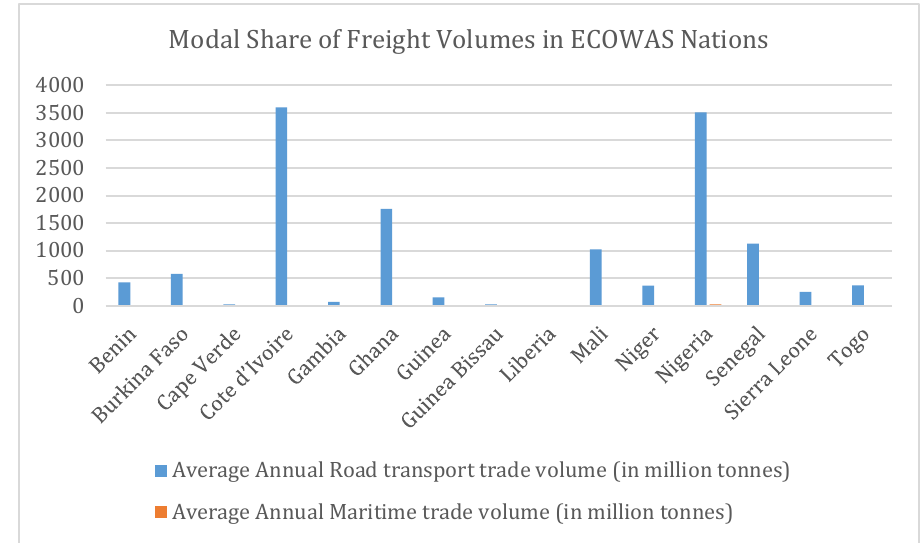
Figure 2: Modal Share of Freight Volumes in ECOWAS Nations from